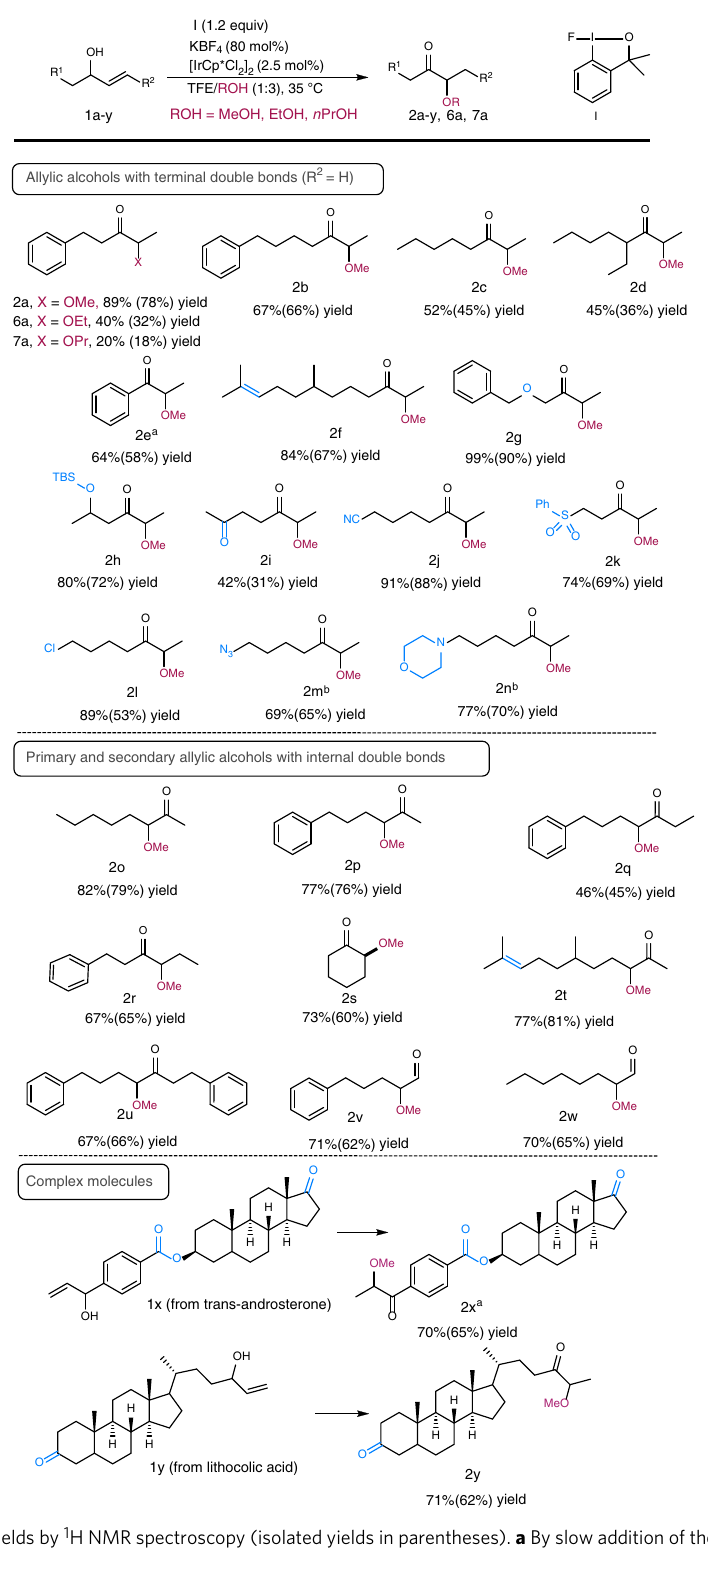
Fig. 3 Scope of allylic alcohols 1 . Yields by 1 H NMR spectroscopy (isolated yields in parentheses). a By slow addition of the reactants. b From 2l in a one-pot two-step